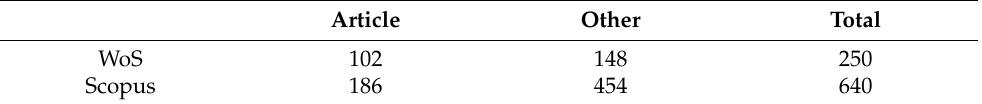
Table 5. The number of papers from Web of Science (WoS) and Scopus bibliographic